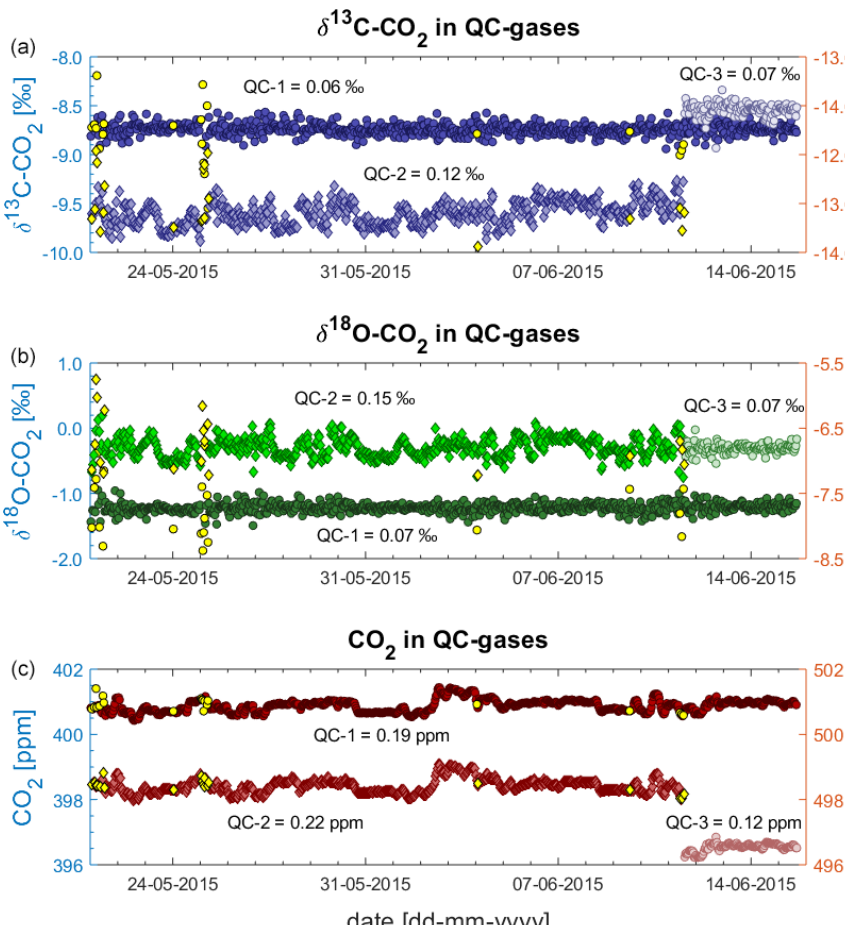
Figure 9. QC gas data as measured against Ref-1 during deployment at BHD: δ 13 C-CO 2 (a) , δ 18 O-CO 2 (b) and CO 2 mole fractions (c) . QC-1 and QC-3 on left y axes; QC-2 on right y